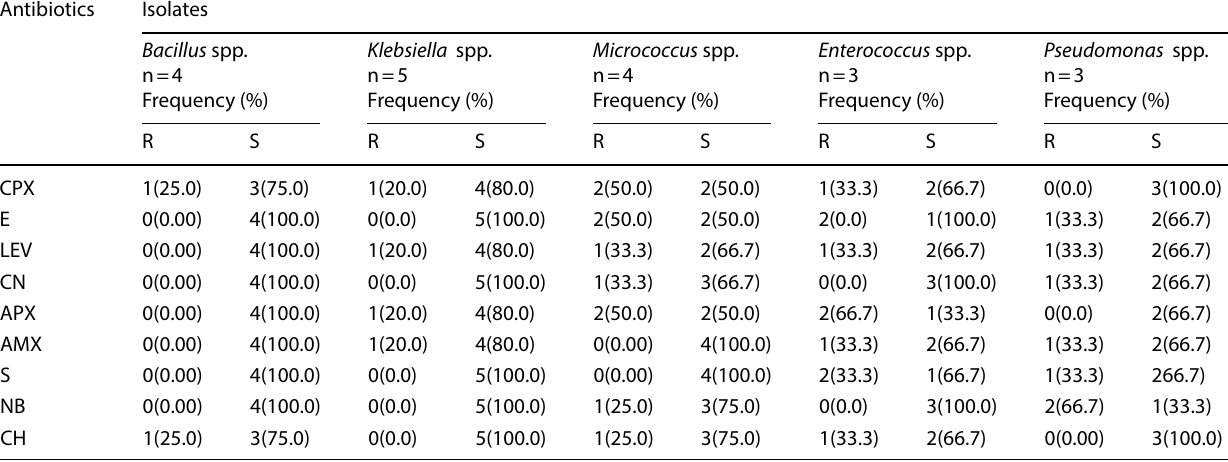
Table 3 Antibiotic susceptibility profile of isolates from control soil